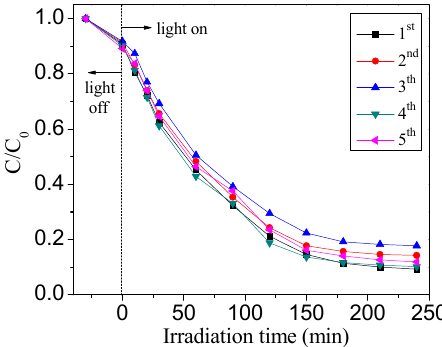
Figure 11. Effect of relative humidity on the removal efficiency of HCHO by different catalysts under visible light irradiation for 240 min.